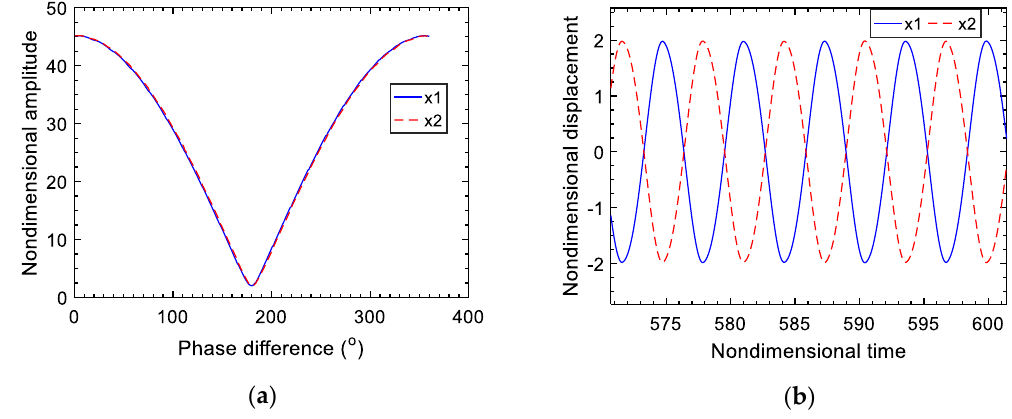
Figure 6. Vibration reduction performance of the dual-connected SSDI (PP) with respect to the phase difference: ( a ) amplitude of x1 and x2 DOFs with respect to the phase difference; ( b ) steady-state response of x1 and x2 when the phase difference of excitation is 180 degree.